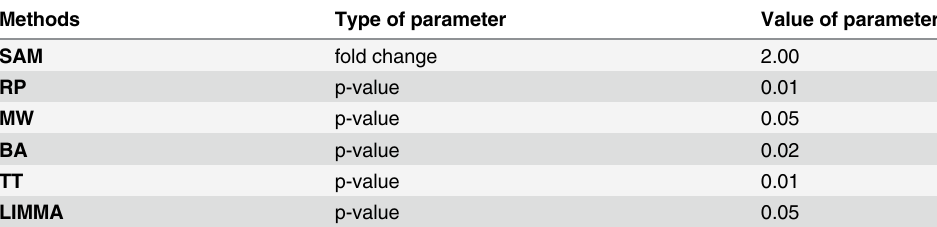
Table 3. Parameters that were fixed for each method of high-level analysis (for the purpose of experiments).